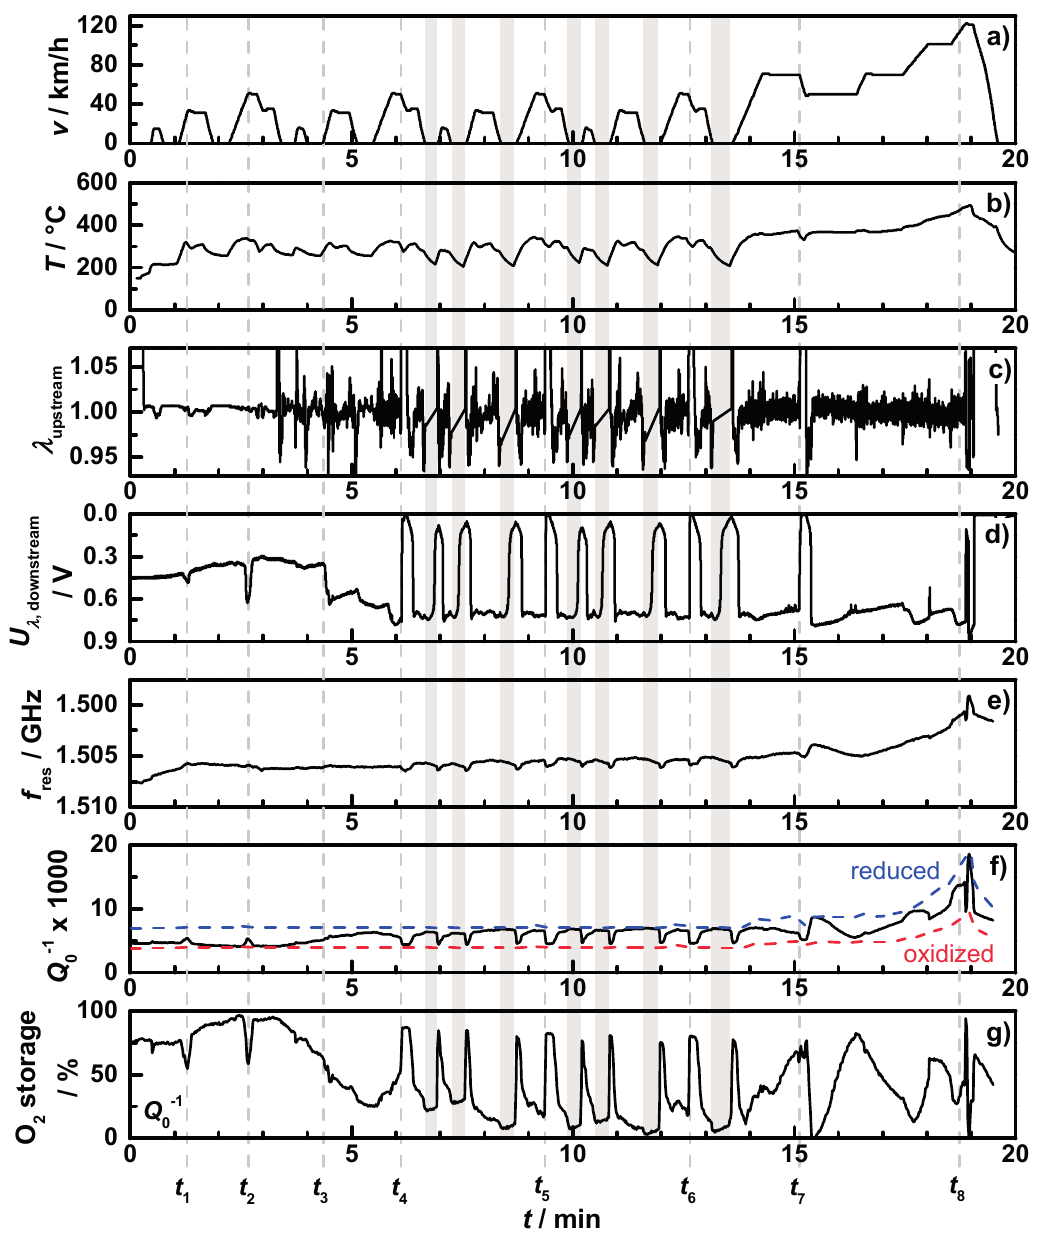
Figure 7. NEDC measurement with warm start conditions for sample C1 : ( a ) vehicle speed; ( b ) downstream exhaust gas temperature; ( c ) the air-fuel ratio λ measured by the upstream broadband lambda probe; ( d ) downstream lambda probe signal; ( e ) resonance frequency in reverse scale; ( f ) reciprocal quality factor with characteristic lines for temperature dependent reduced (blue) and oxidized (red) state and ( g ) the oxygen storage degree calculated by the quality factor and the characteristic lines. Start-stop phases with engine shut off are shaded